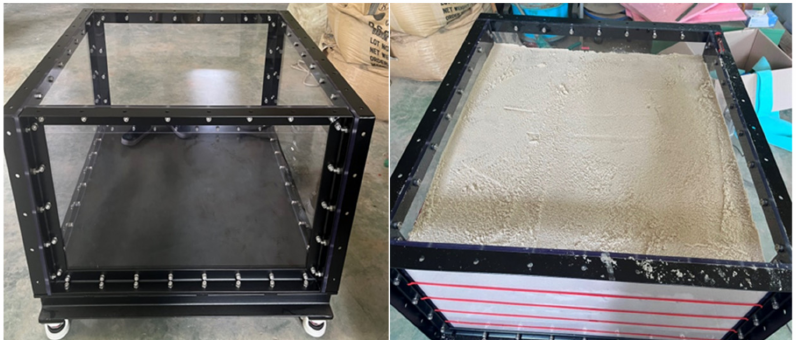
Figure 9. Ground